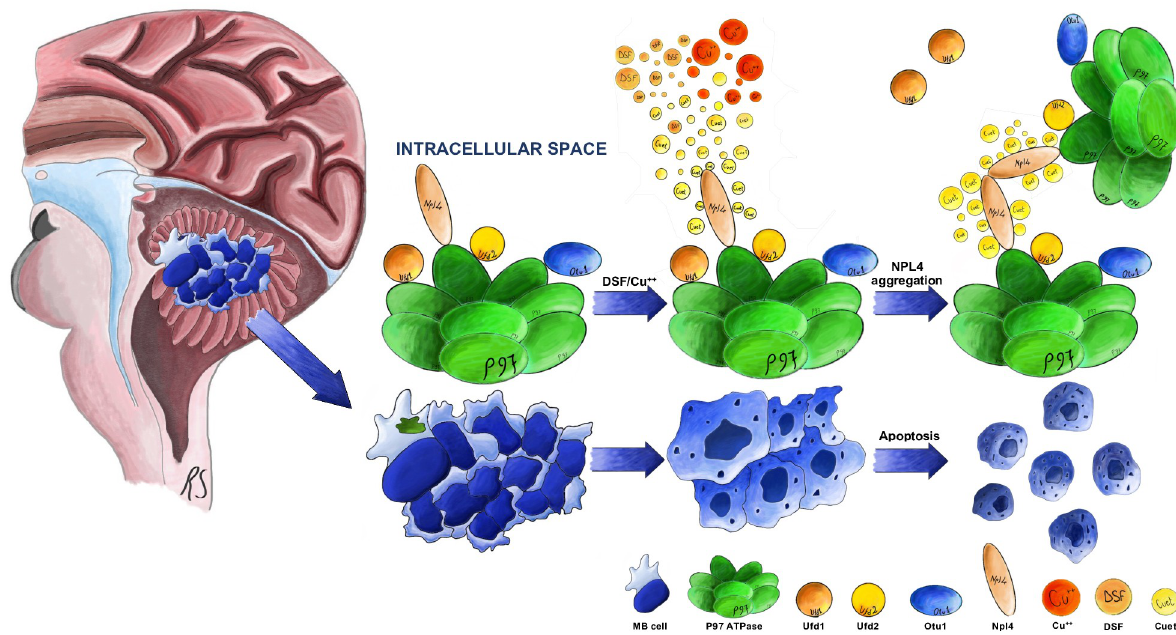
Fig 6. Molecular targets of DSF-Cu ++ . Schematic of the molecular mechanisms of action of DSF-Cu ++ .